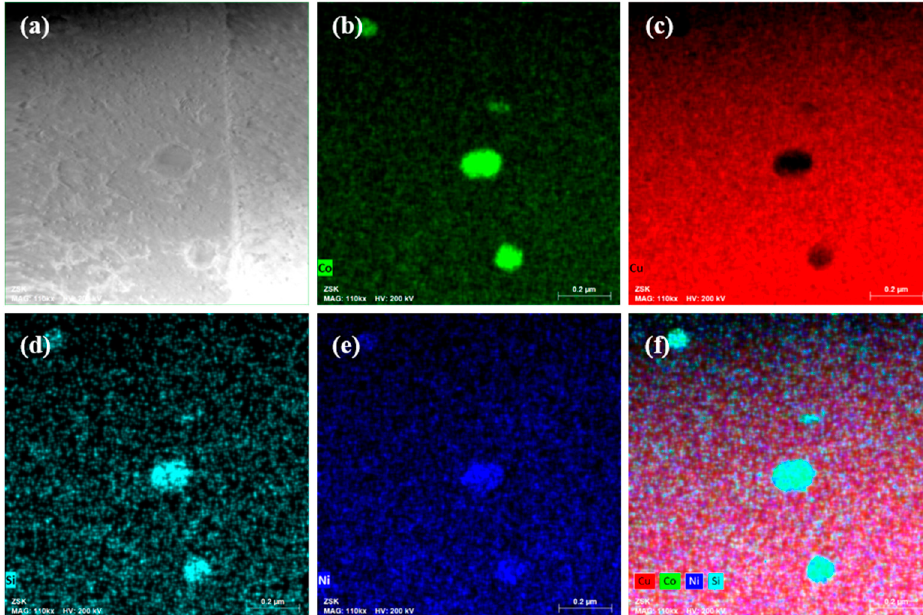
Figure 6. EDS map of precipitates: ( a – f ) EDS mapping of different elements in the